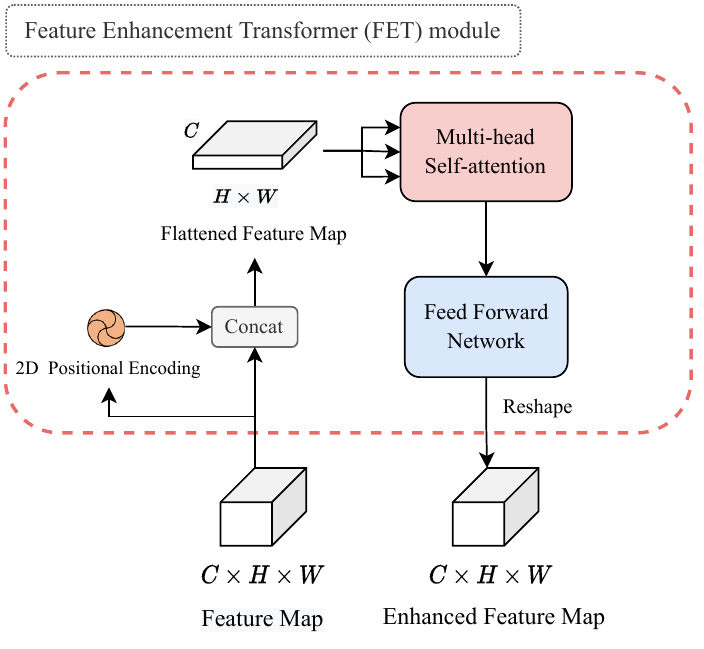
Figure 5. Illustration of FET module with self-attention modules using 2D absolute positional